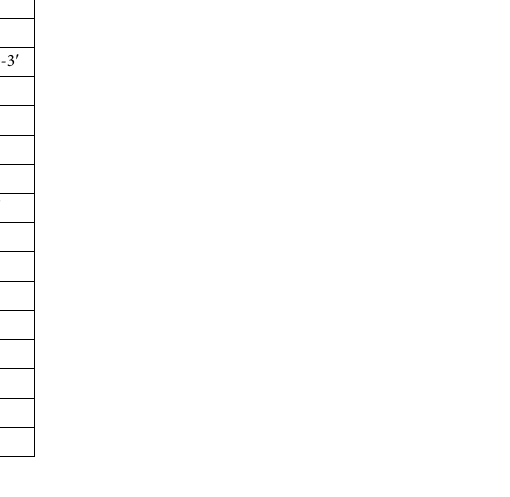
Table 1. Primers used in this